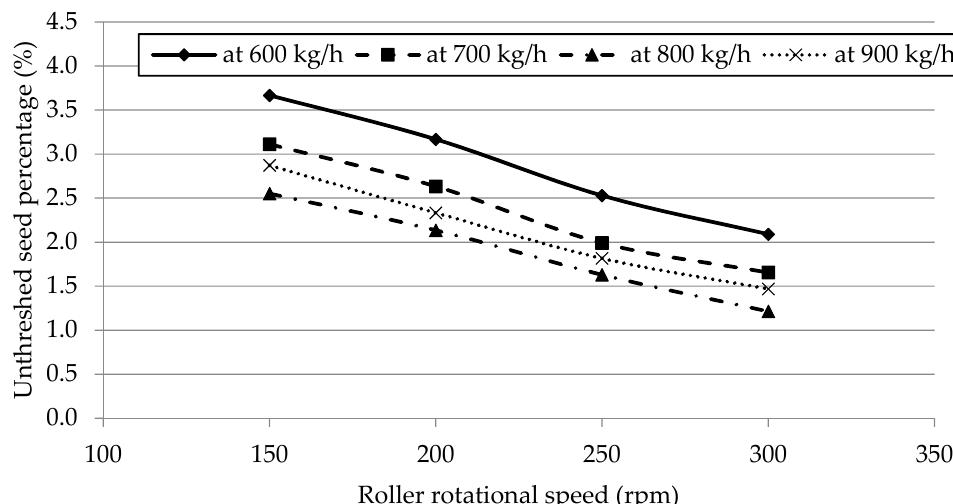
Figure 5. Effect of the roller’s rotational speed (rpm) on the unthreshed seed percentage (%) at different feed rates (kg/h). 3.3. Effect of the Roller’s Rotational Speed on the Threshing Efficiency at Different Feed Rates